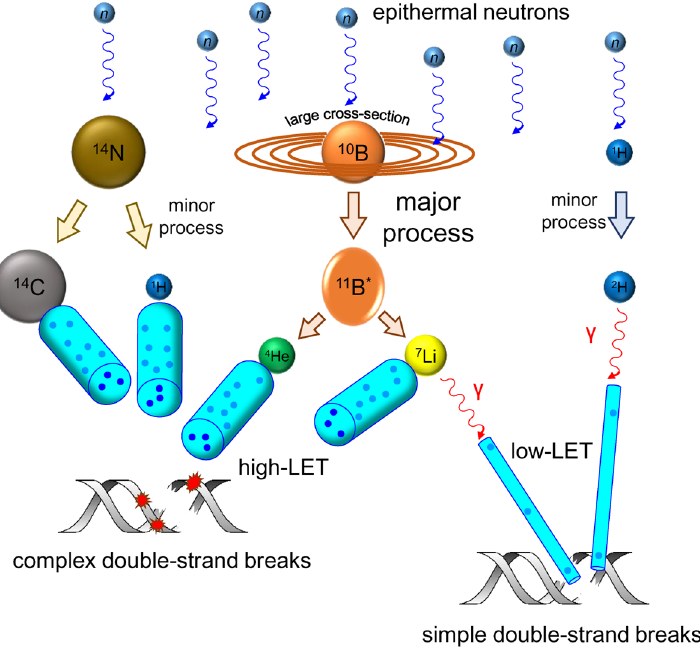
Figure 1. Schematic depiction of nuclear reactions, ionization processes, and DNA damage taking place during BNCT.